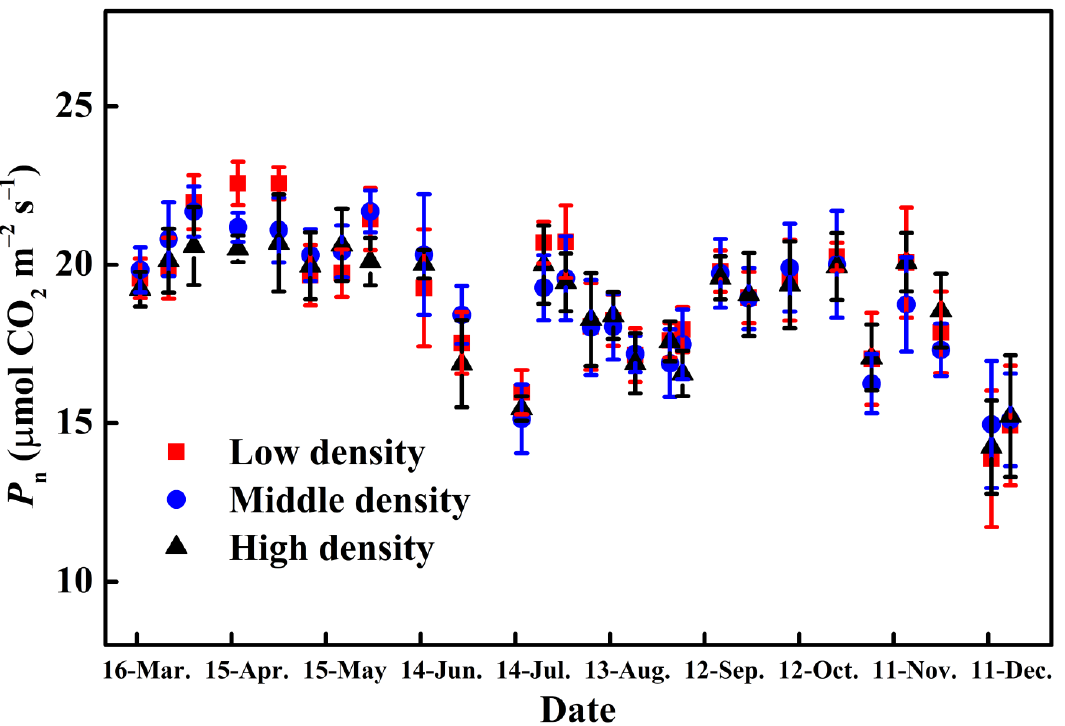
Figure 5. Changes of cucumber net photosynthetic rate ( P n ) of different density treatments in three cultivation periods. The data represent the mean ± SD (n = 6).